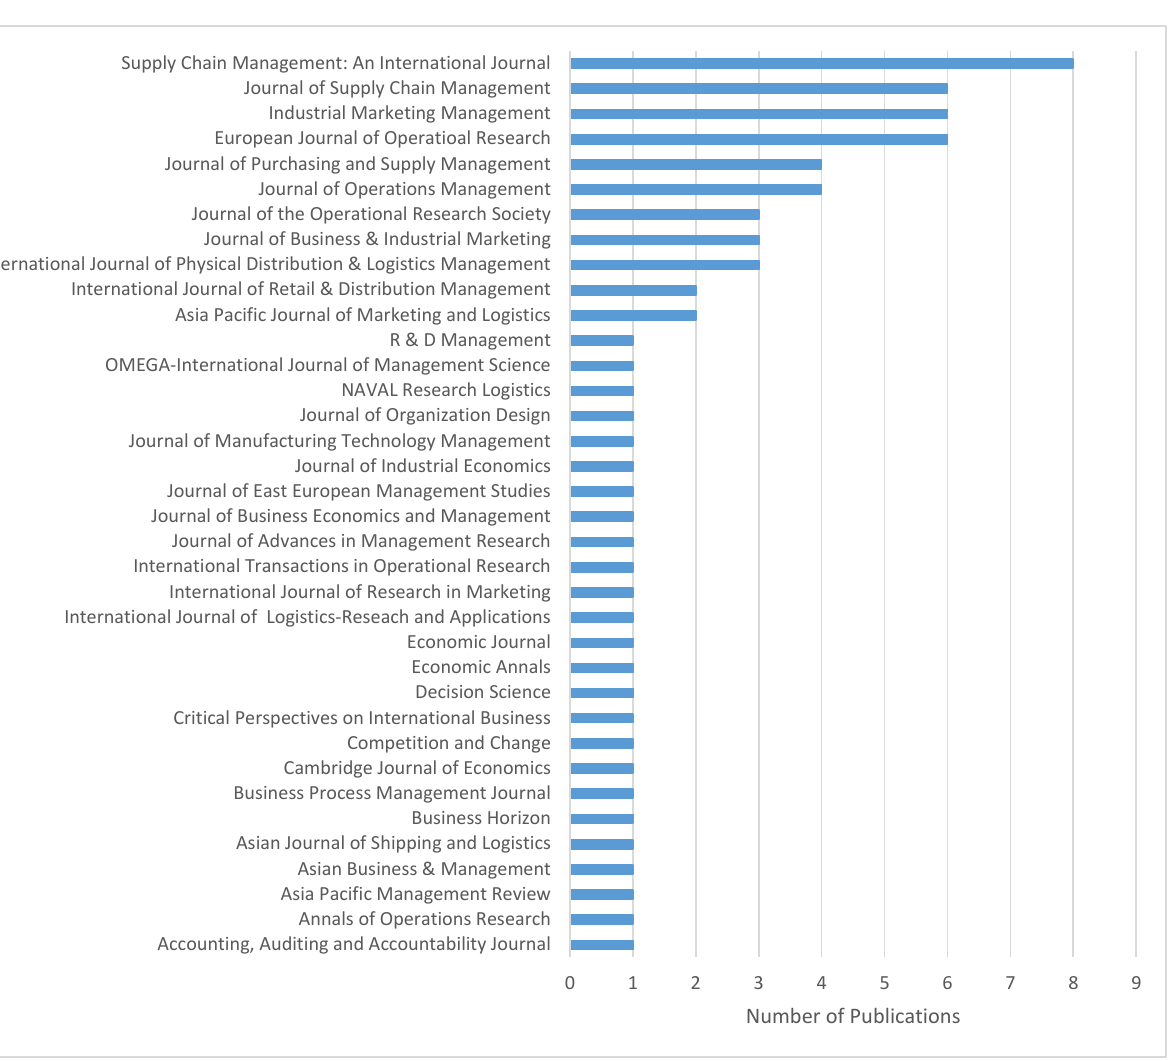
Figure 3. Number of publications per